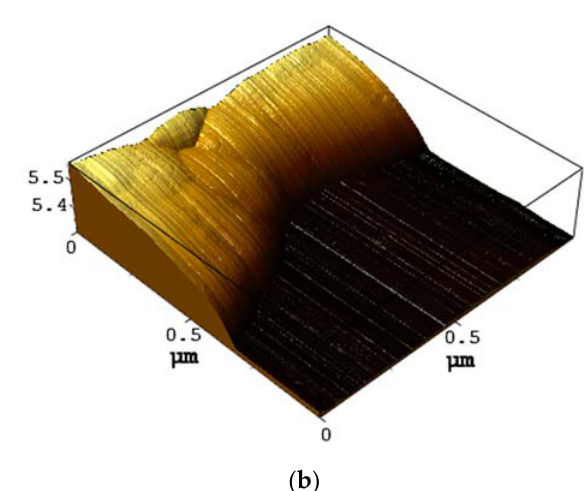
Figure 2. SEM images of ( a ) CVD graphene grown on a Cu foil; ( b ) high ‐ resolution SEM image showing graphene irregularities, such as flakes, wrinkles, and holes.